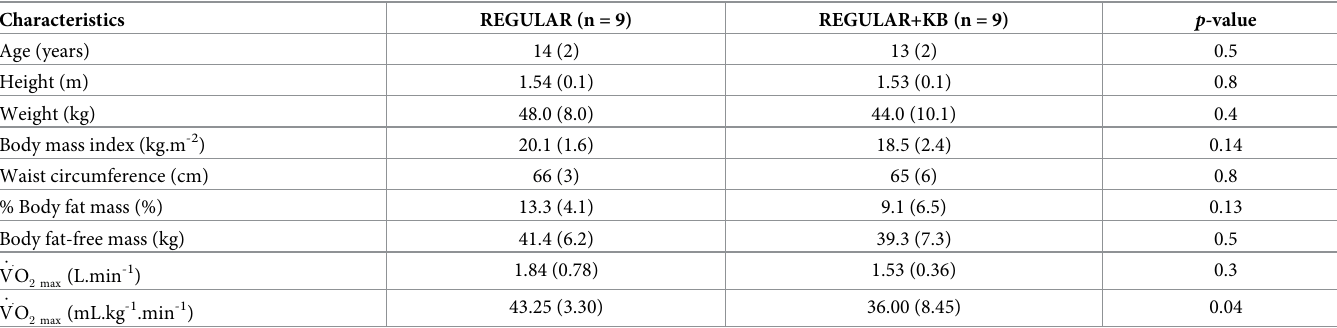
Table 1. The characteristics of the participants.